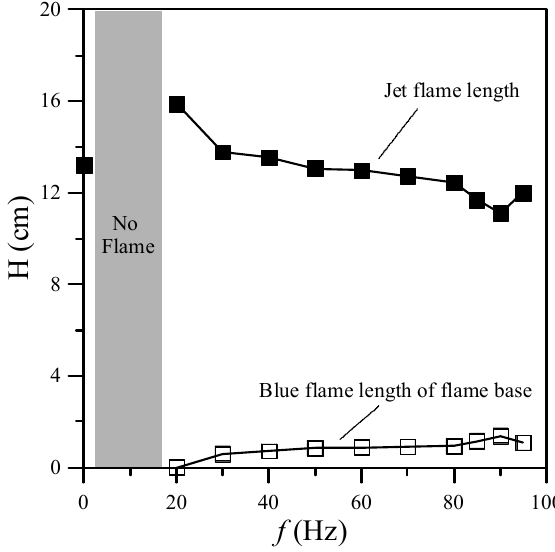
Figure 3. Flame lengths and blue flame lengths of flame base at various excitation